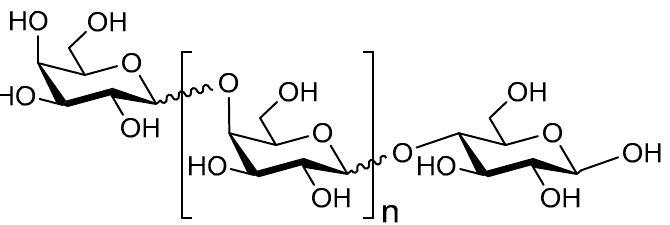
Figure 5. Structure of the main components of GOS; 1,4–linked and 1,6–linked β –galactose and a reducing-end glucose.